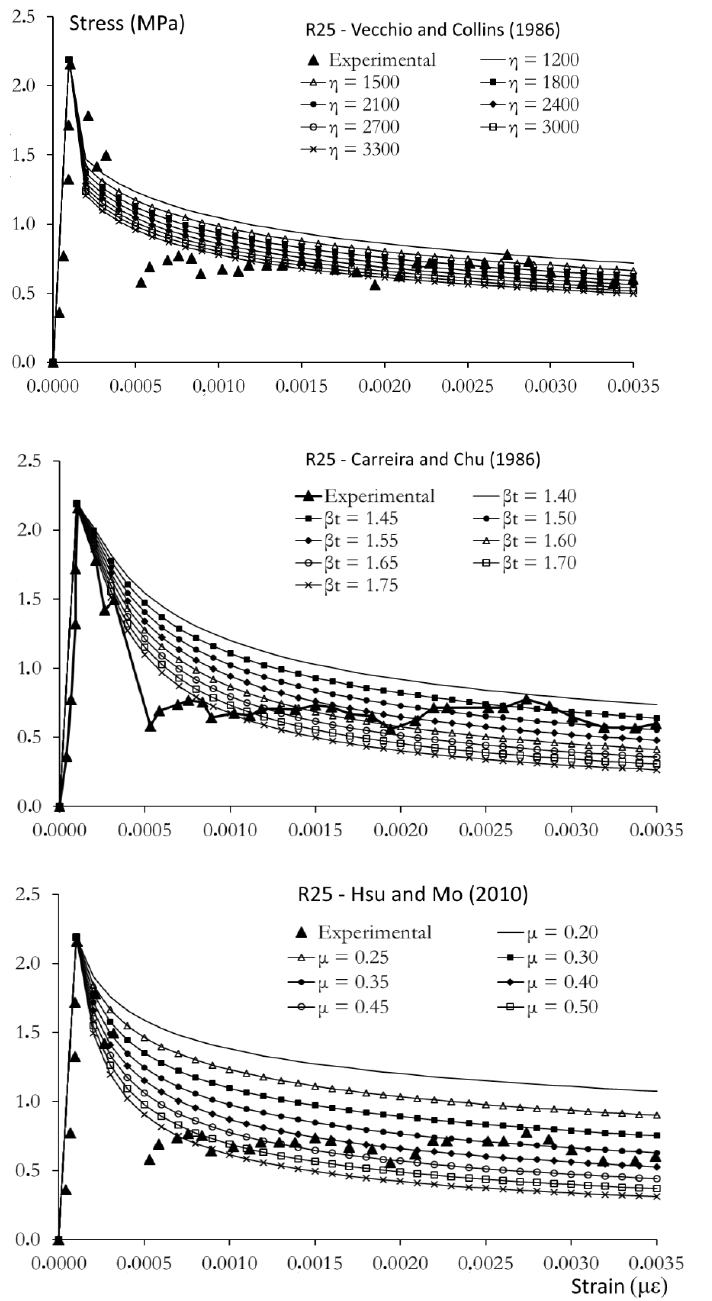
Figure 9. Parametric study of analytical models for the R25 tension stiffening